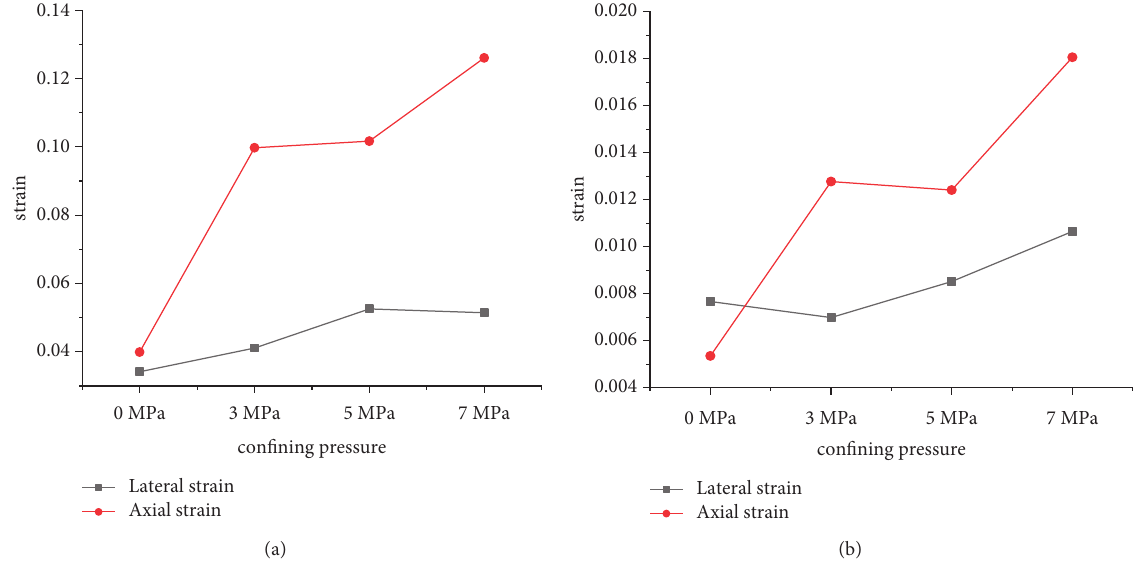
Figure 7: Peak strain characteristic diagrams. (a) Lateral strain and axial strain at peak stress of elastic deformation. (b) Lateral strain and axial strain at peak